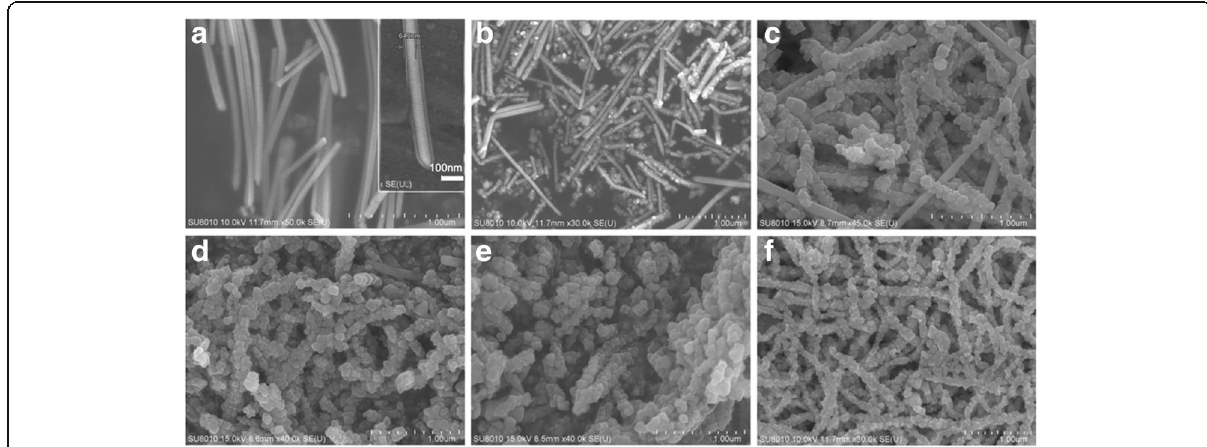
Fig. 2 SEM images of a Ag nanowires and Ag@AgCl core – shell nanowires with different mole ratio of Ag:AgCl. Ag@AgCl core – shell nanowires were synthesized through the reaction between 250 μ L Ag nanowire dispersion and b 0.5, c 1.0, d 1.5, e 2.0, and f 2.2 mL of 20 mM FeCl 3 solution